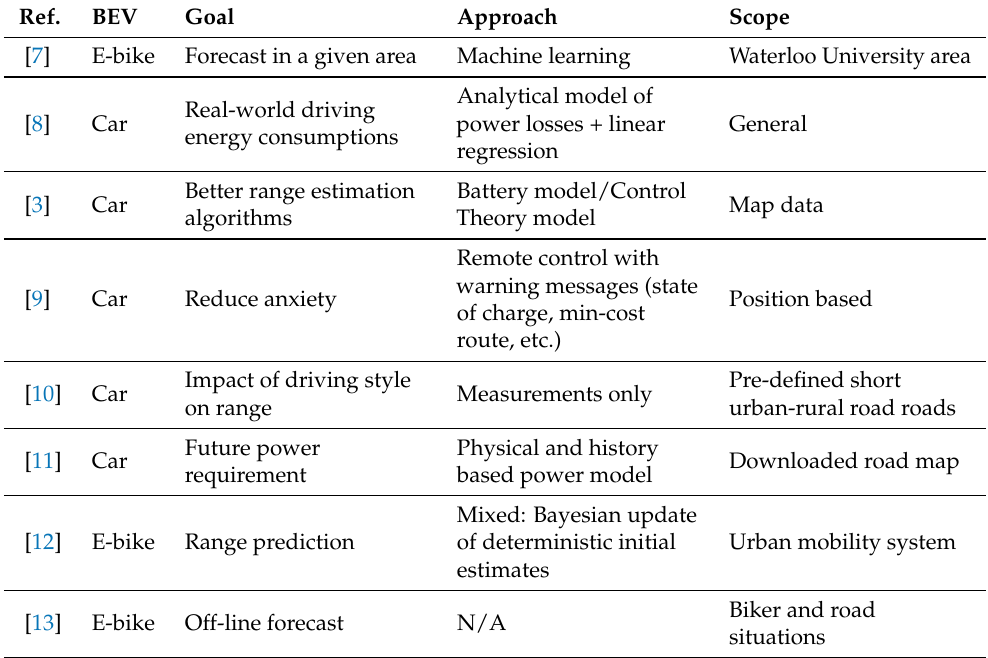
Table 1. Related work